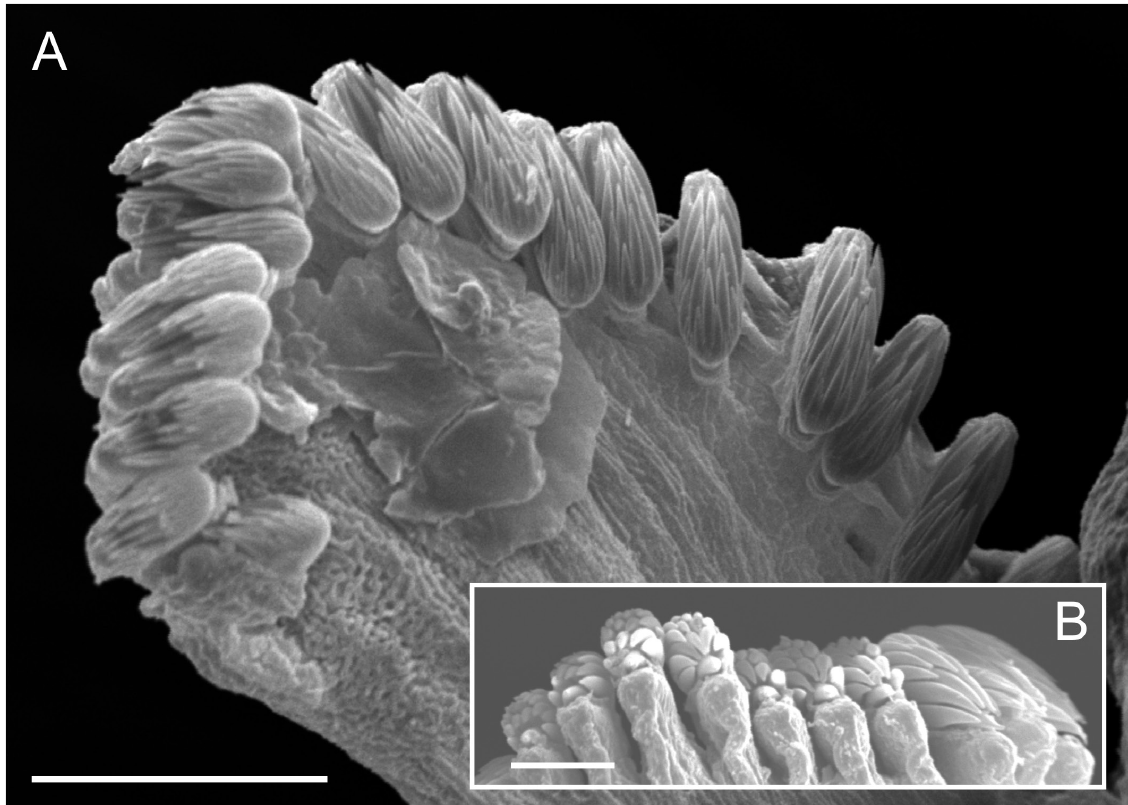
Fig. 6. Ampharete oculicirrata sp. nov., paratype MNCN 16.01/18482_spec. 3. A . Abdominal unciniger 7, posterior view. B . Detail of abdominal uncini, frontal and lateral view. Scale bars: A =150 µm; B = 5